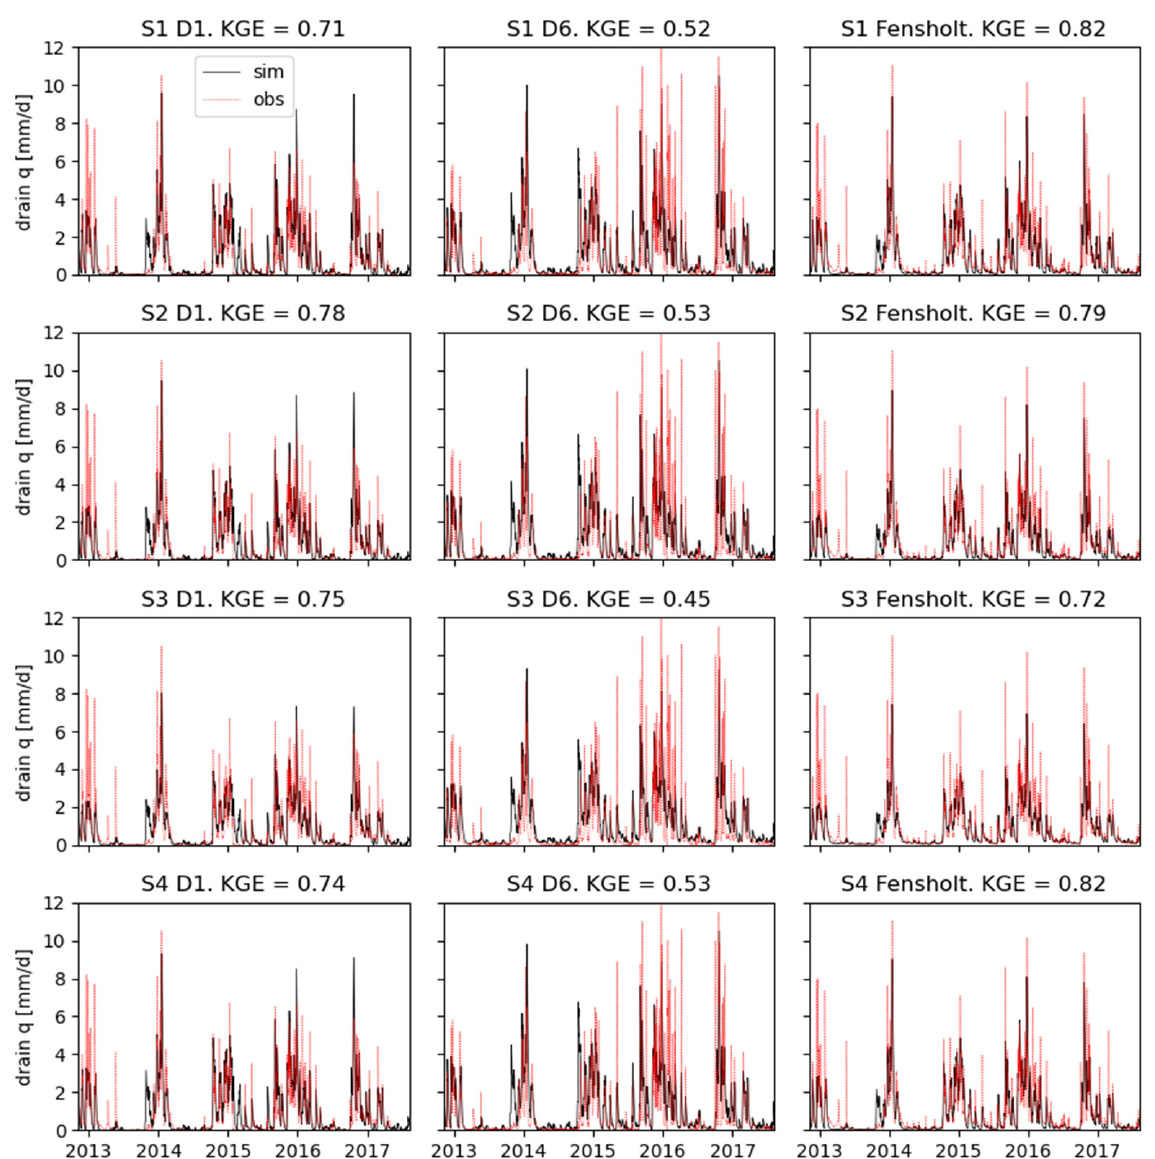
Figure 5. Simulated drain flow vs. observed drain flow shown for two examples of the eight drain catchments, and across the entire Fensholt sub-catchment. Each row shows the results from one of the scenarios S1 to S4.